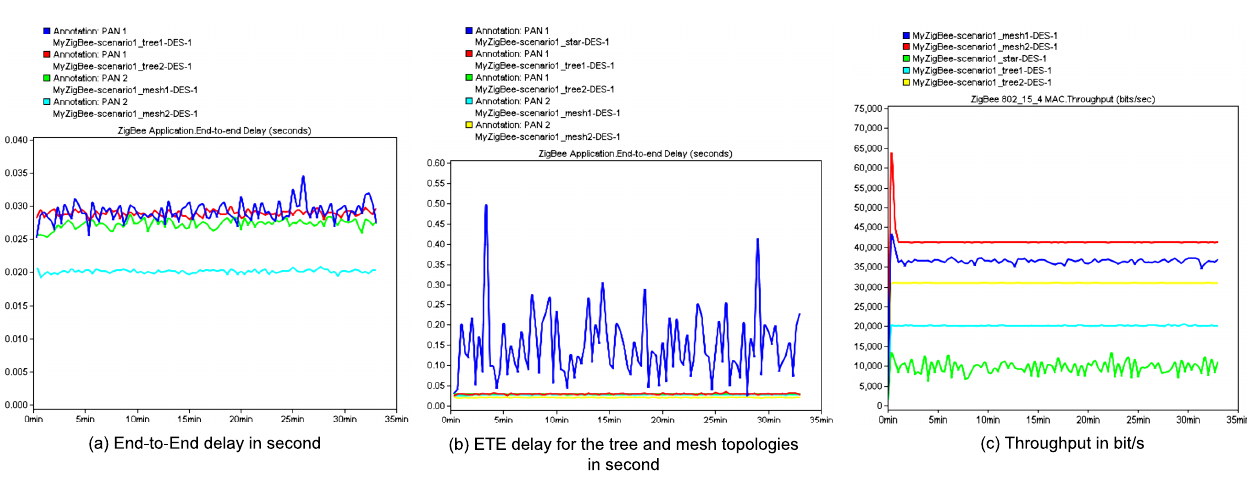
Figure 4. Set of results from scenario 1 with 20